Question: What does this figure show? Answer in one sentence.
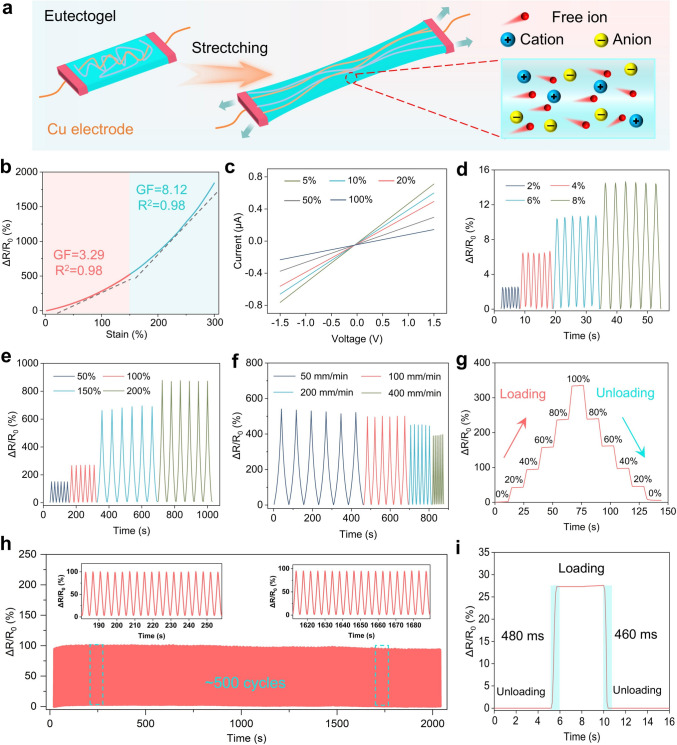
Answer: Strain-sensing performance of DPF-Zn@LNP-HEG. a Schematic of the eutectogel-based strain sensor. b Δ R / R 0 as a function of applied strain (0–300%) underwater. c Current–voltage (I-V) curves under tensile strains from 5 to 100%. d, e Δ R / R 0 under small (2–8%) and large strains (50–200%). f Δ R / R 0 at strain rates of 50–400 mm min −1 (100% strain). g Δ R / R 0 under stepwise strain (0–100%). h Cycling stability tested at 50% strain and stretching speed of 500 mm min −1 . i Response and recovery times